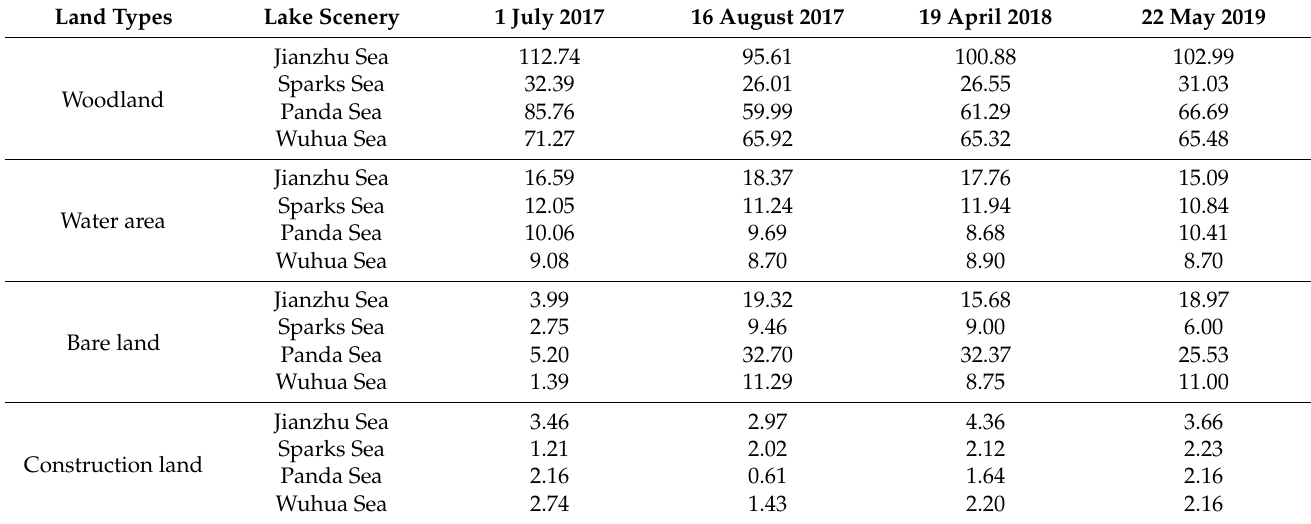
Table 5. Comparison of the area changes in different periods before and after the earthquakes (km 2